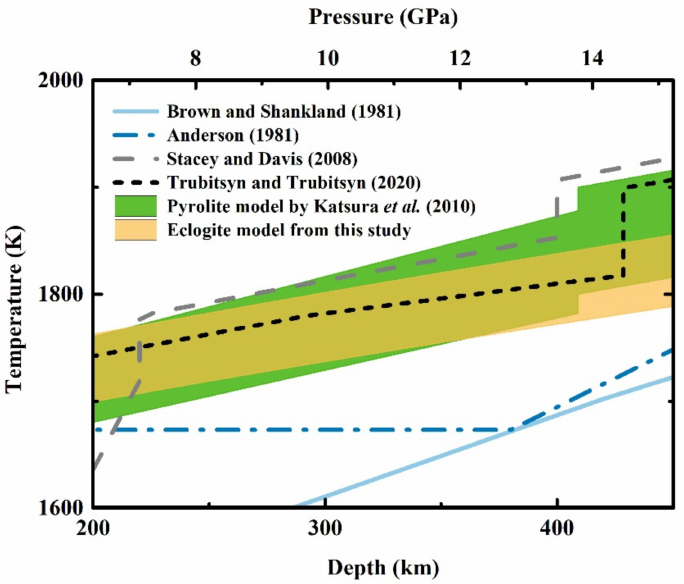
Figure 9. Adiabatic geotherm in the depth range of 200–450 km. The lower and upper edges of the filled area are calculated with T P as 1623 K and 1683 K,